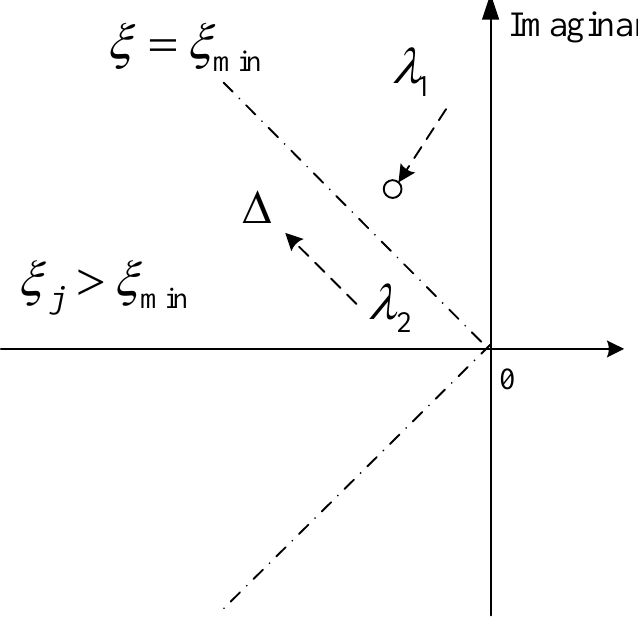
Figure 2. The left region of s-plane.